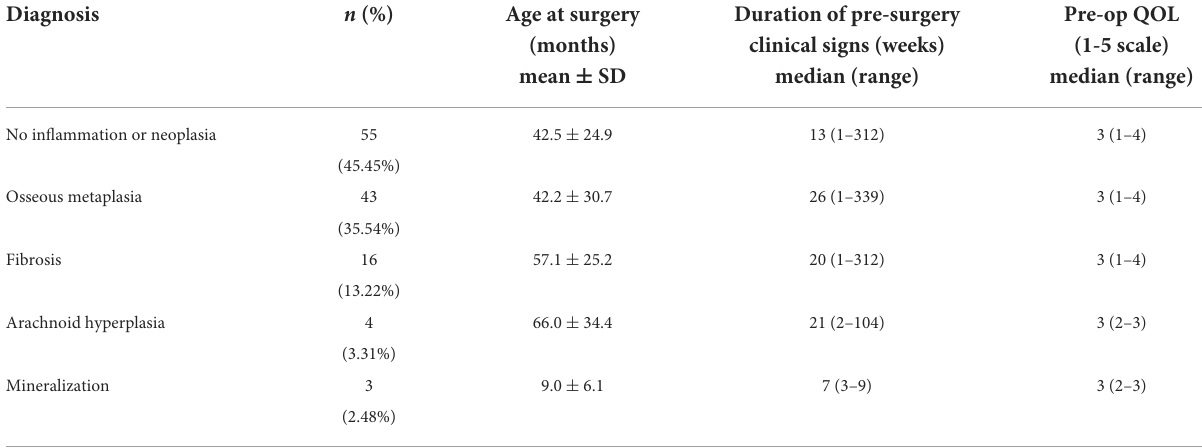
TABLE 2 Histological diagnosis of dura in 121 dogs with surgically corrected